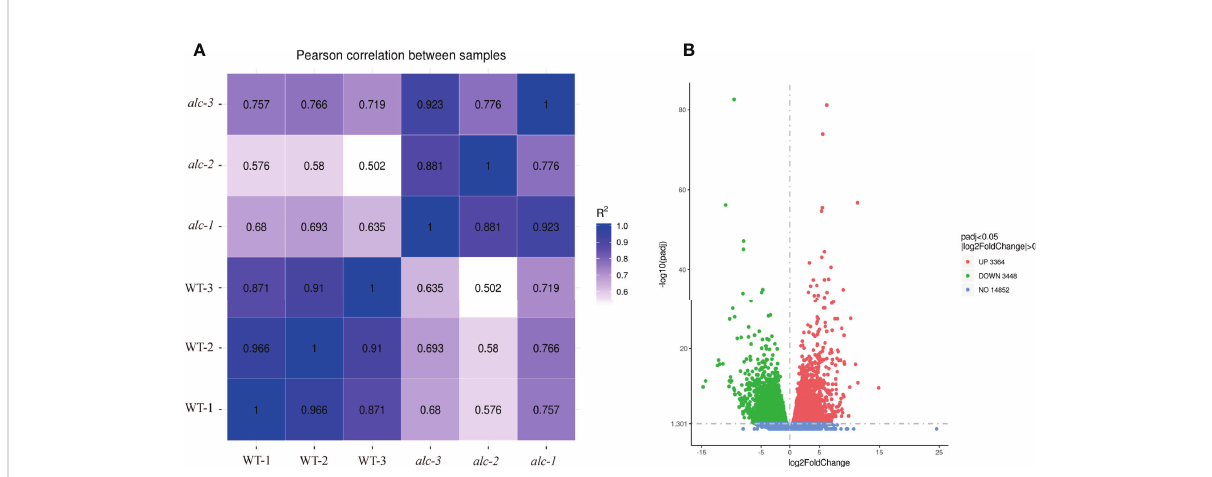
FIGURE 3 Diagrams illustrating correlations/distances among transcriptomes and the number of differentially expressed genes in alc mutant and wild type seedlings. (A) Correlation matrix and cluster dendrogram of the whole dataset of the mapped reads. The analysis was performed by comparing the values of the entire transcriptome of all two samples with three biological replicates. Correlation analysis (coef fi cients R 2 ) and hierarchical cluster analysis were performed using R software. Dark blue color indicated a stronger correlation and light blue weaker (R 2 ). (B) Volcano plot showing DEGs between alc mutant and wild type. X-axis represented log2(Fold Change) and y-axis represents -log10 (padj). Red, green and blue dots represented up-regulated, down-regulated and not DEGs,